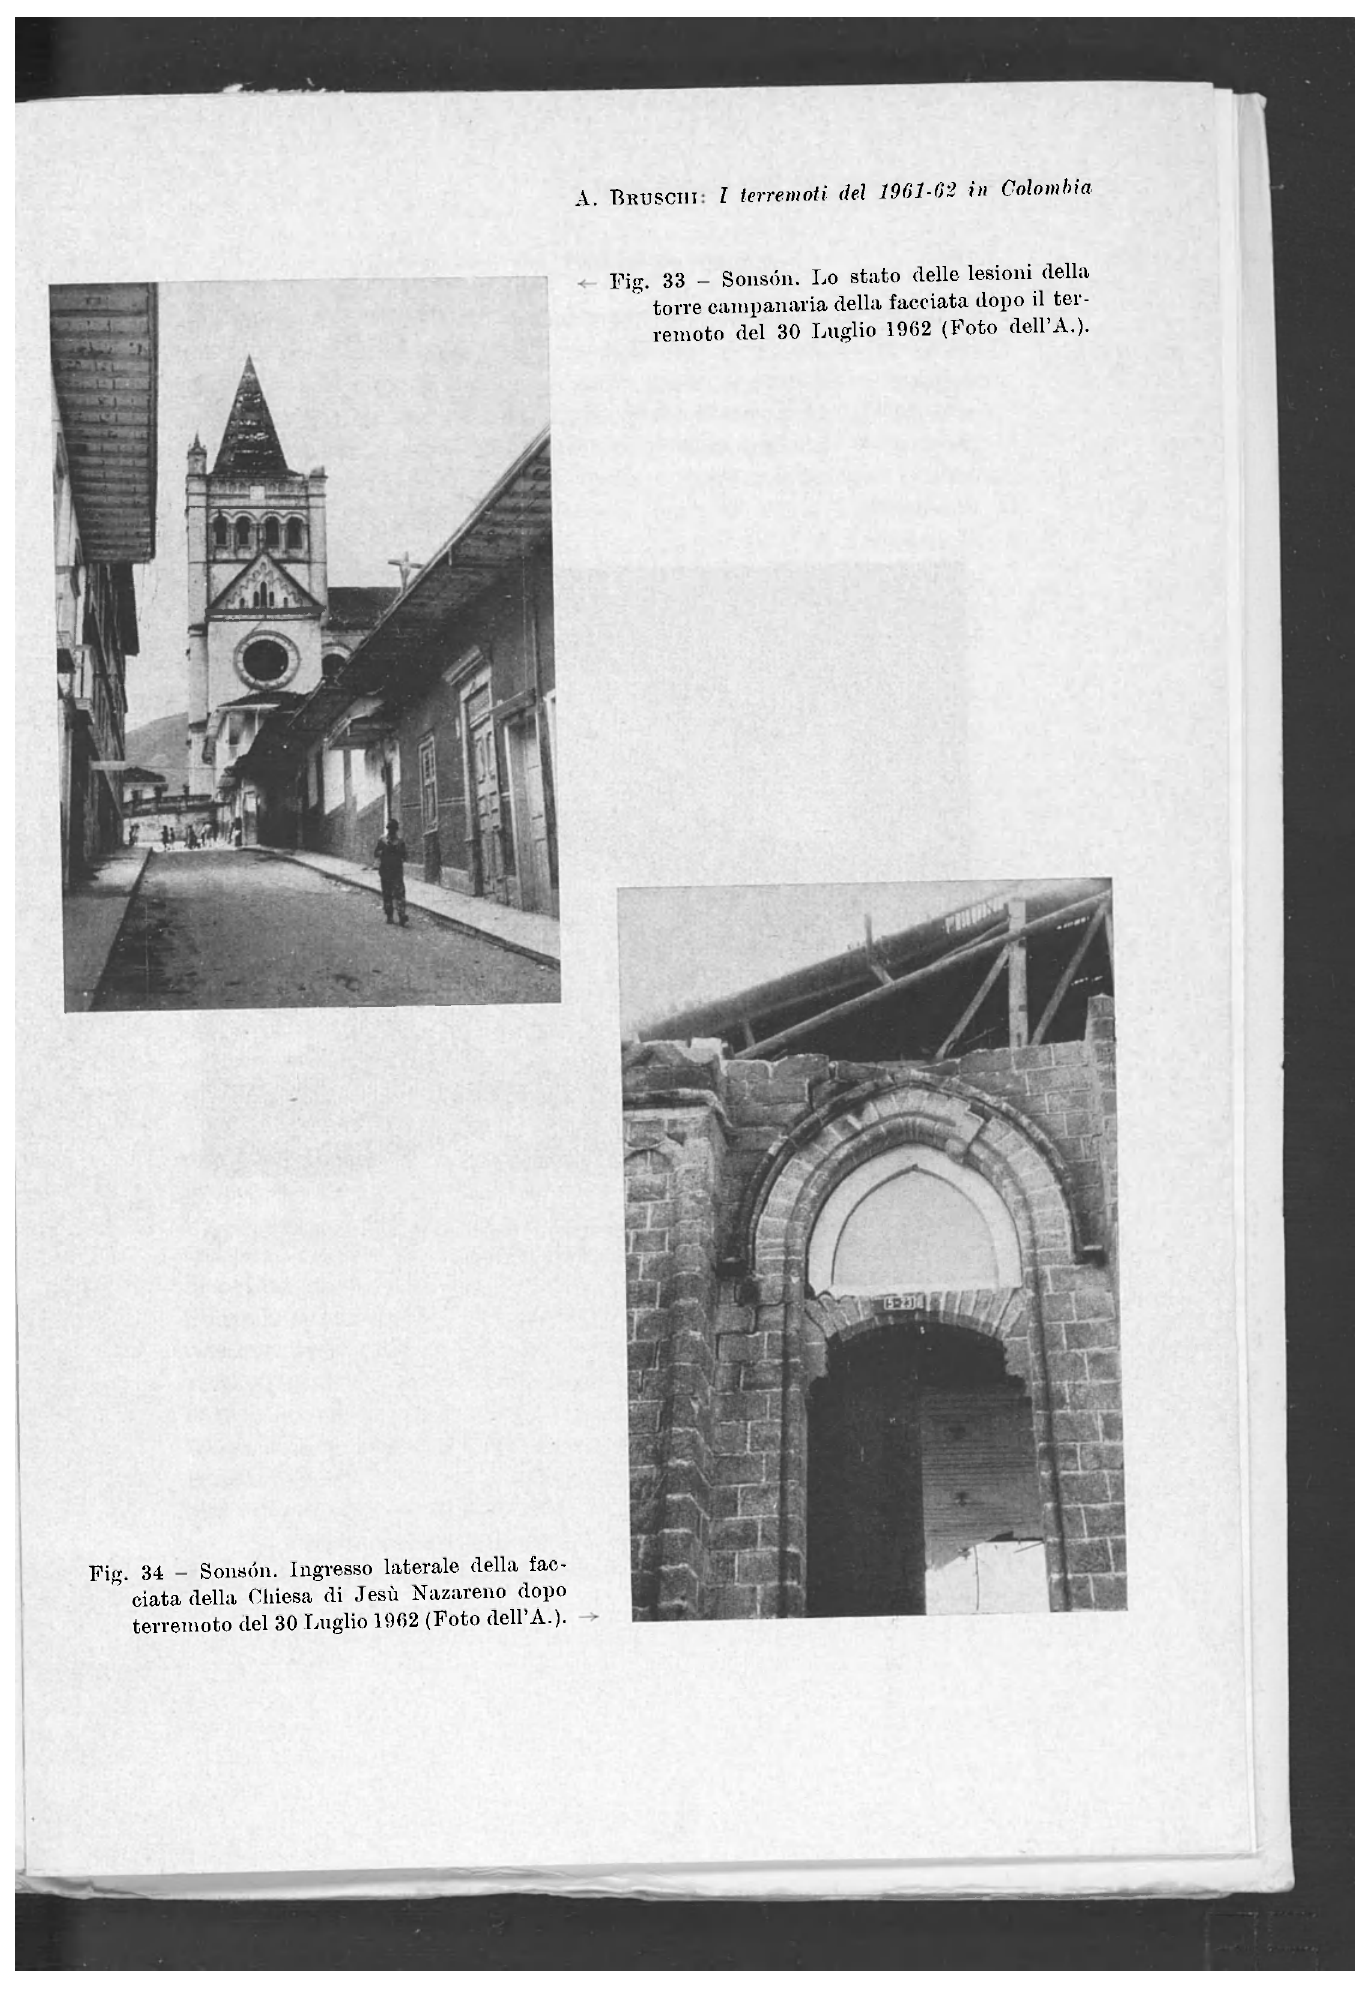
Fig. 33 - Sonsón. Lo stato delle lesioni della torre campanaria della facciata dopo il ter- remoto del 30 Luglio 1962 (Foto